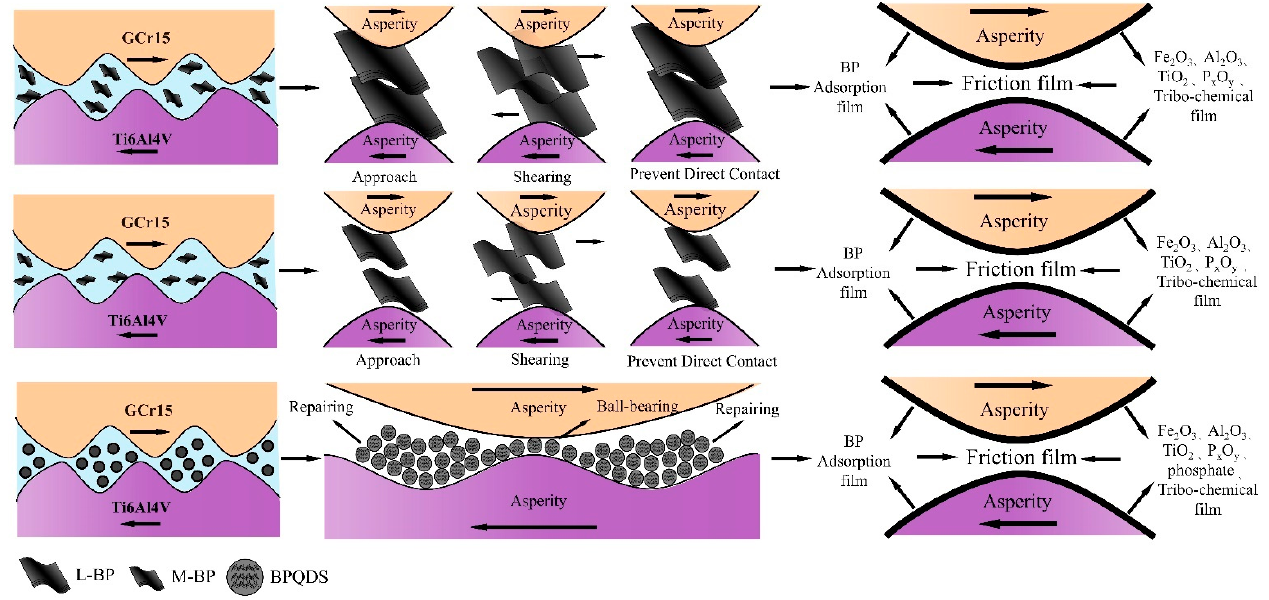
Figure 12. Schematic of lubrication mechanism of L-BP, M-BP, and BPQD